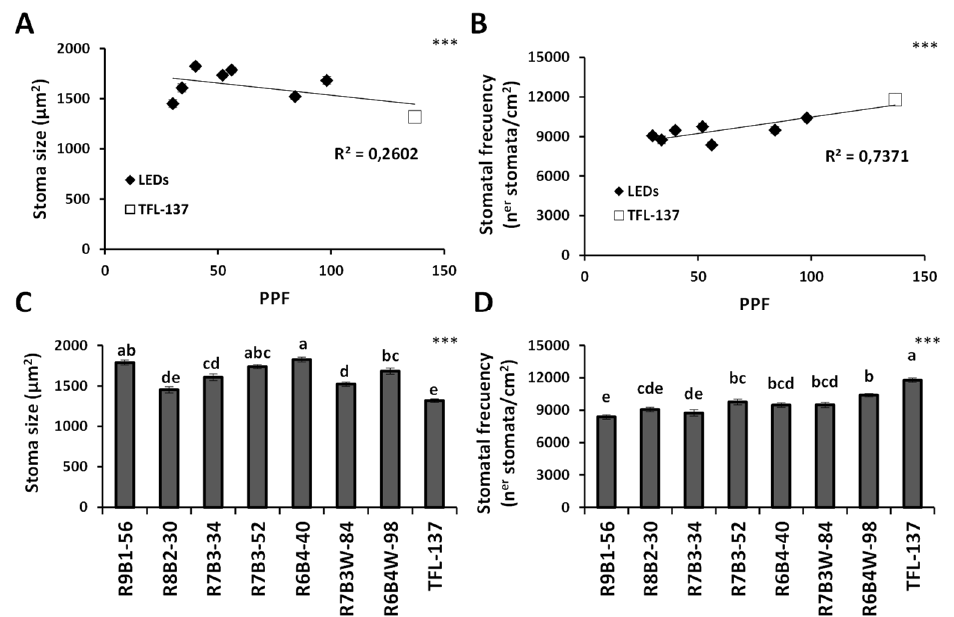
Figure 5. Effect of illumination quality and quantity on stomatal size and frequency. Correlation of light intensity with the stomatal size ( A ) and the stomatal frequency ( B ) in in-vitro grown AMK34 plants. Effect of different illumination regimes from light-emitting diodes (LEDs) and fluorescent lighting (TFL-137) on the stomatal size ( C ) and the stomatal frequency ( D ) in in-vitro grown AMK34 plants. PPF, photosynthetic photon flux. Levels of significance: *** p ≤ 0.001.